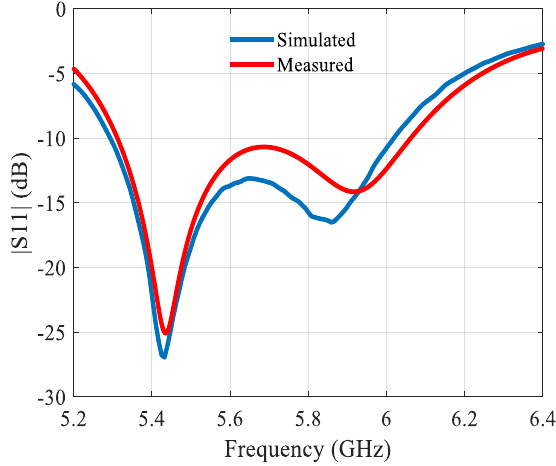
Figure 9. Reflection coefficient of the 2 × 1 building block with an air layer.